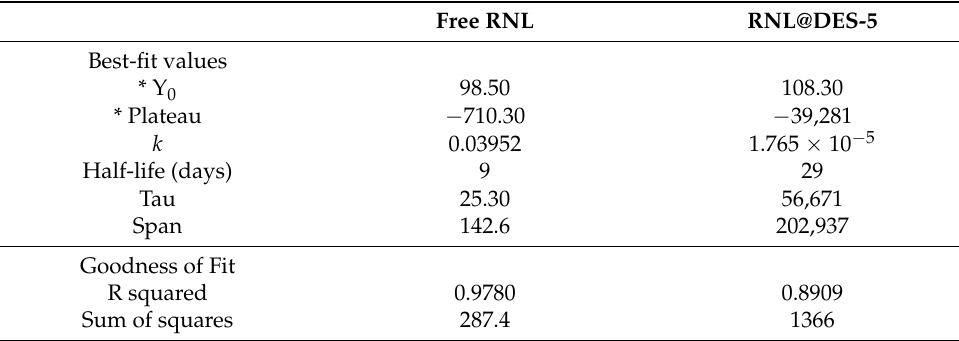
Table 3. One phase non-linear decay model of free and activated lipase.